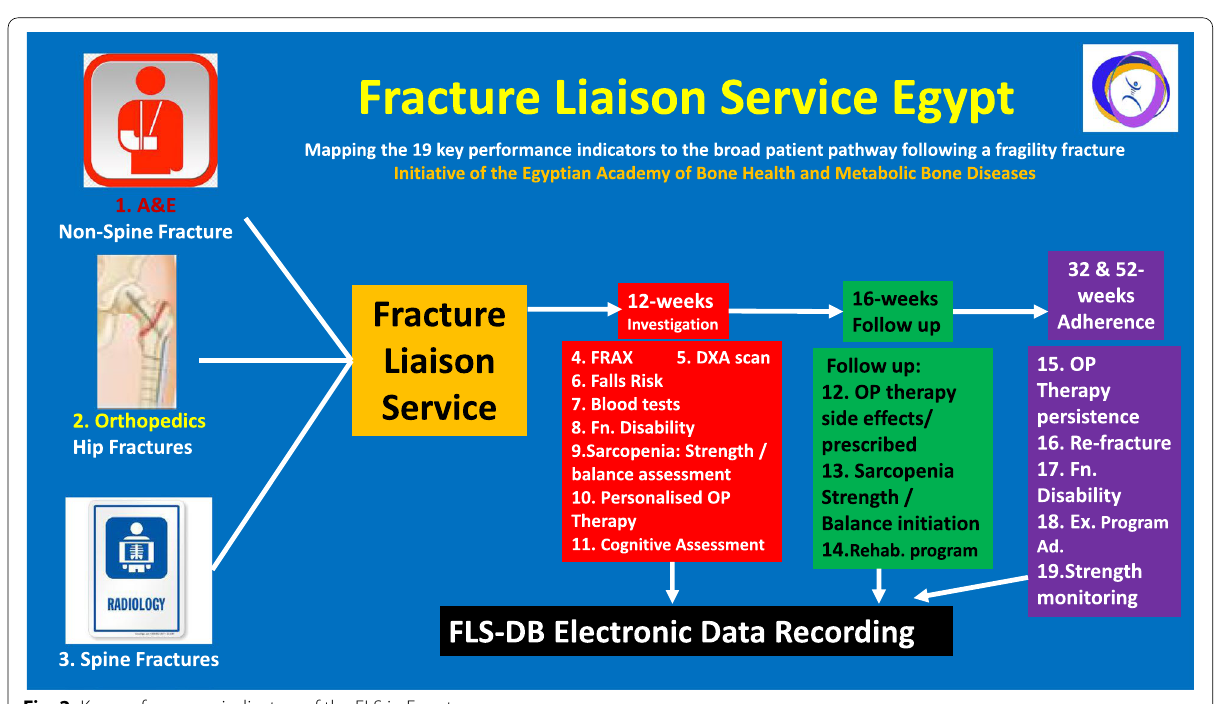
Fig. 2 Key performance indicators of the FLS in Egypt